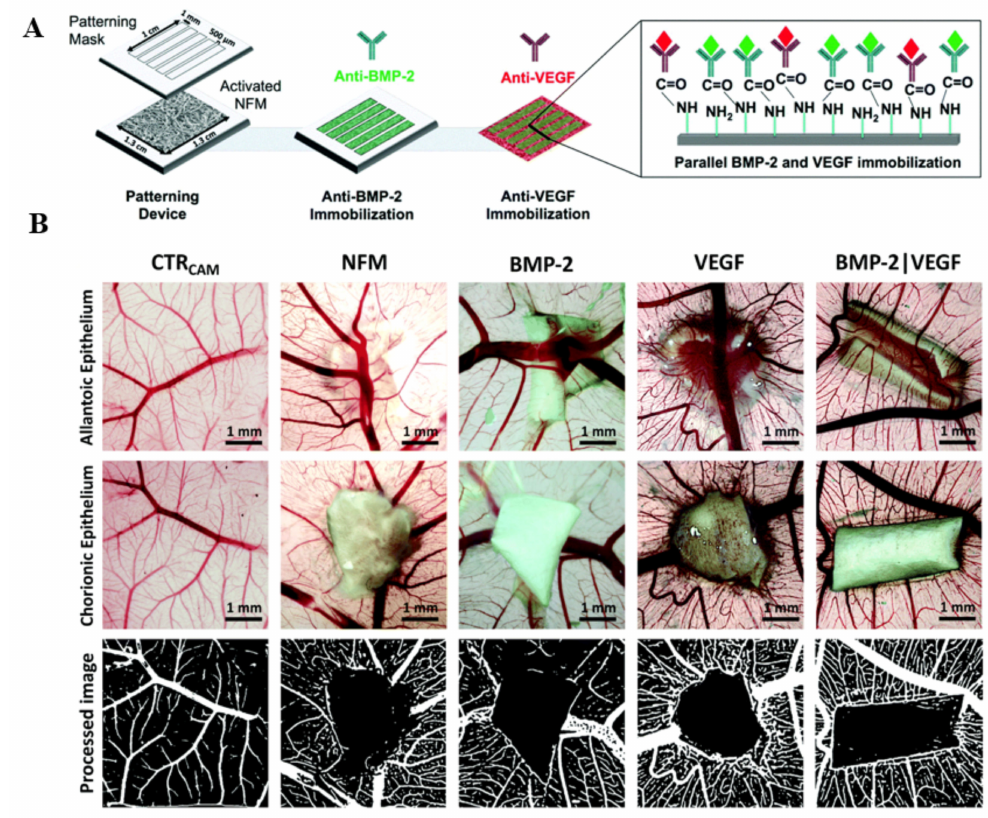
Figure 6. ( A ) Schematic of activated electrospun PCL nanofibers immobilized with anti-BMP-2 and anti-VEGF; ( B ) Schematic of vascularization in bone defect area. Reproduced with permission from [103]. Copyright Remaking Singapore